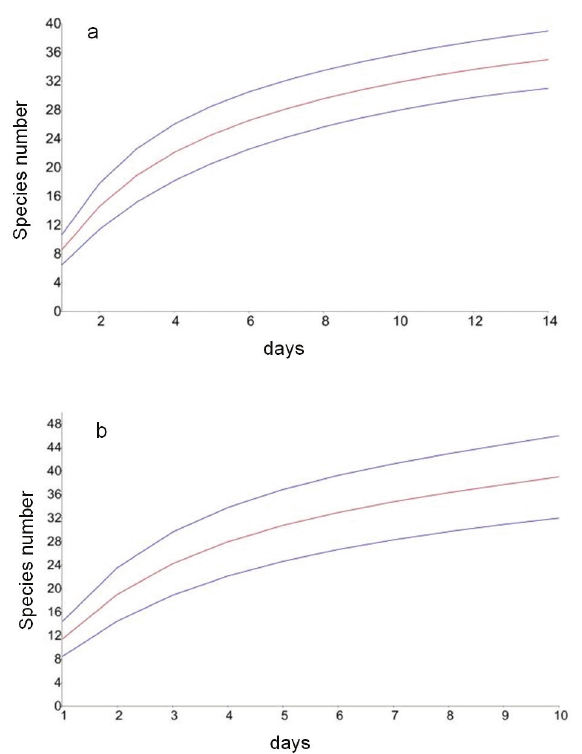
Figure 7. Permutated species accumulation curves (=sam- ple-based rarefaction curve; red line: mean, blue lines: 95% confidence intervalls) of amphibian species richness in a the Krahn-Bassa Proposed Protected Area in eastern Liberia and b the Foya Proposed Protected Area in western Liberia during the March/April 2018 survey. Y-axis: estimated amphibian species richness, x-axis: sample units (each comprising six to 16 man/ hour surveys in different localities within the respective